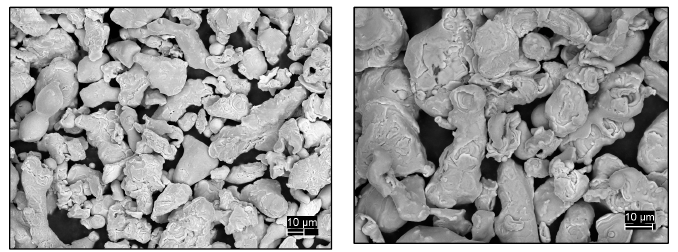
Figure 4. Scanning Electron Micrographs of Cu powder employed as conductive phase.